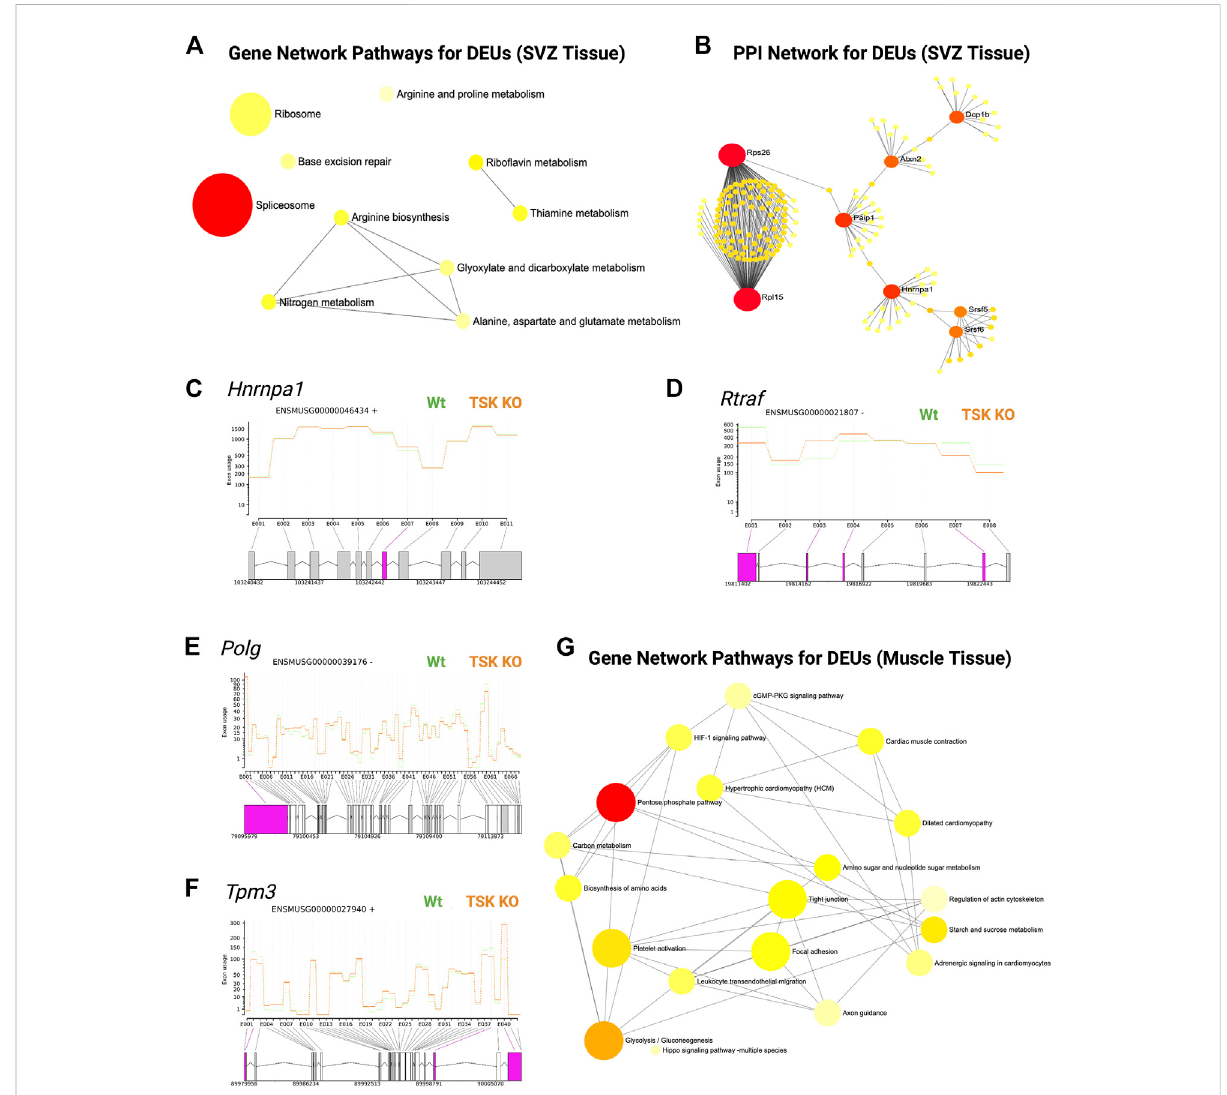
FIGURE 6 TSK regulates the splicing in SVZ and muscle tissues. (A) Gene-set enrichment network of SVZ genes with DEU using signi fi cantly enriched KEGGpathwayfunctionalcategories( p < 0.05).Thenodesrepresentenrichedpathwaygenesets.Thesizeofthenodeisproportionaltothenumber of relevant genes in the set. The p -value of the node is indicated by the yellow to red gradient. Edges (gray lines) indicate shared genes between two nodes. (B) NetworktopologyofspliceosomeSVZDEUgenesbystringdatabase-basedanalysisofprotein-proteininteractions(PPI).Interaction was estimated for a con fi dence score cutoff = 900. All interactions were based on the evidence of physical interactions. Each nodes indicate a protein. The size of the nodes is proportional to their degree values. The color (yellow to red gradient) of the nodes are based on their betweenness centralityvalue.Edges(grayline)indicatesinteractionbetweentwonodes (C) FittedsplicingplotforrepresentativespliceosomeassociatedSVZDEU gene.Pinkindicatesthesigni fi cantdifferentiallyexpressedexon. (D) FittedsplicingplotforposttranscriptionalregulatoryRNAbindingDEUgene.Plot is annotated similar to that in (C). (E) Fitted splicing plot for representative transcription regulatory DNA binding DEU genes in muscle tissue. Plot is annotated similar to that in (C). (F) Fitted splicing plot for representative myo fi brillar gene in muscle tissue. Plot is annotated similar to that in (C).